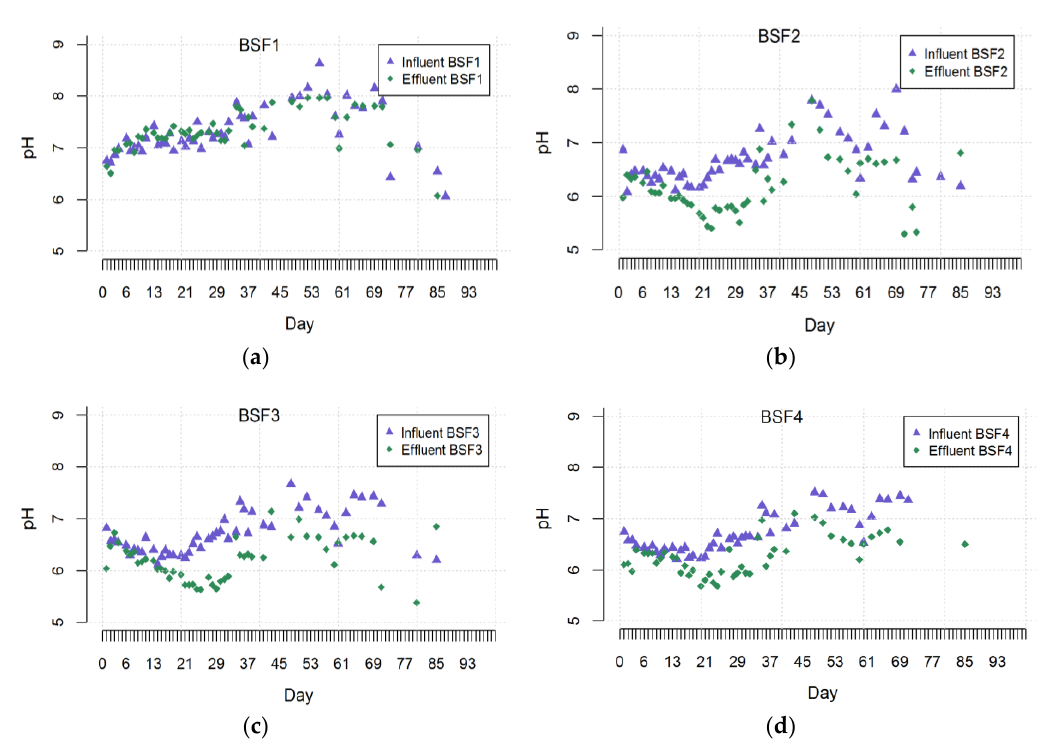
Figure 4. Influent vs. effluent pH over the course of the experiment: ( a ) BSF1, ( b ) BSF2, ( c ) BSF3, and ( d ) BSF4. Water 2020 , 12 , x FOR PEER REVIEW